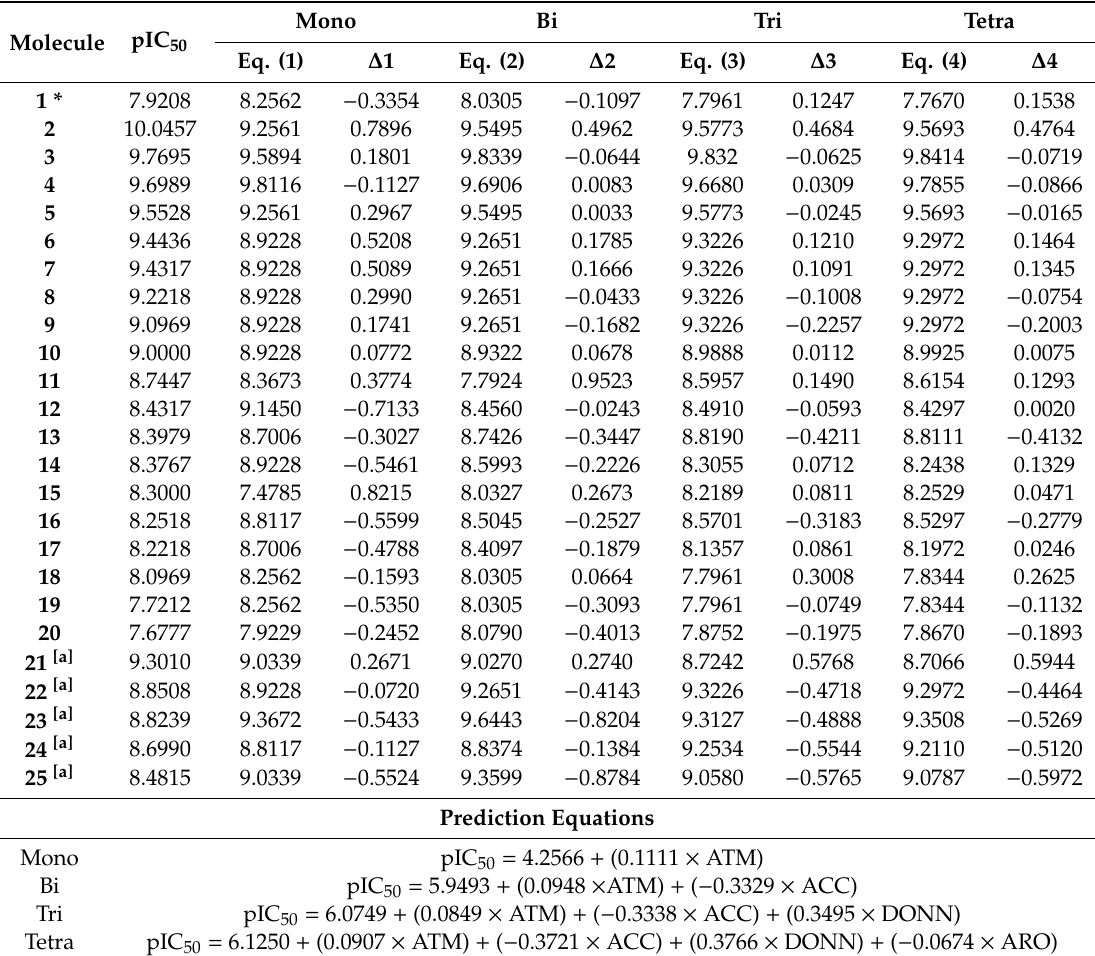
Table 3. pIC 50 values calculated using the prediction